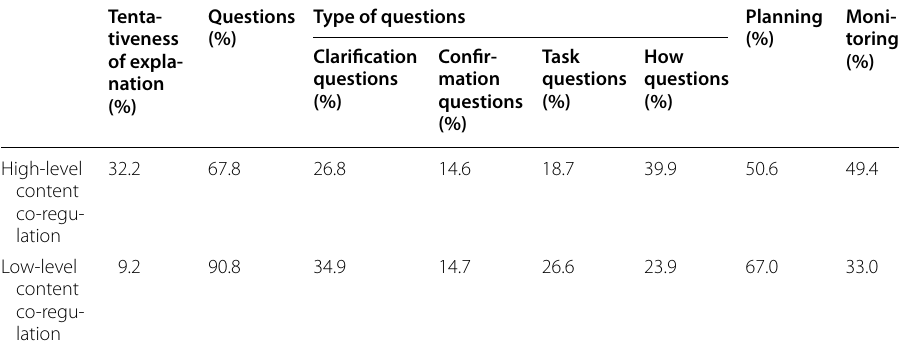
Table 2 Distribution of categorical variables over co-regulation episodes, both high-level and